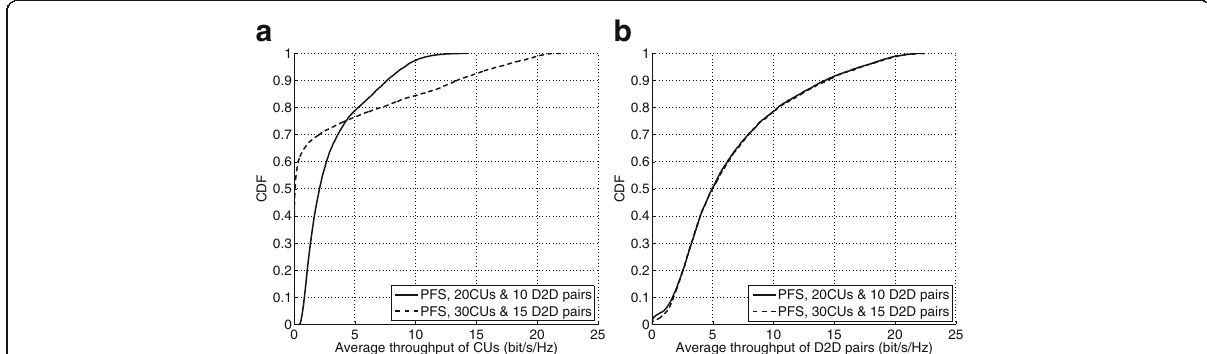
Fig. 8 CDF of average throughput of PFS with different number of CUs and D2D pairs. a CUs. b D2D pairs